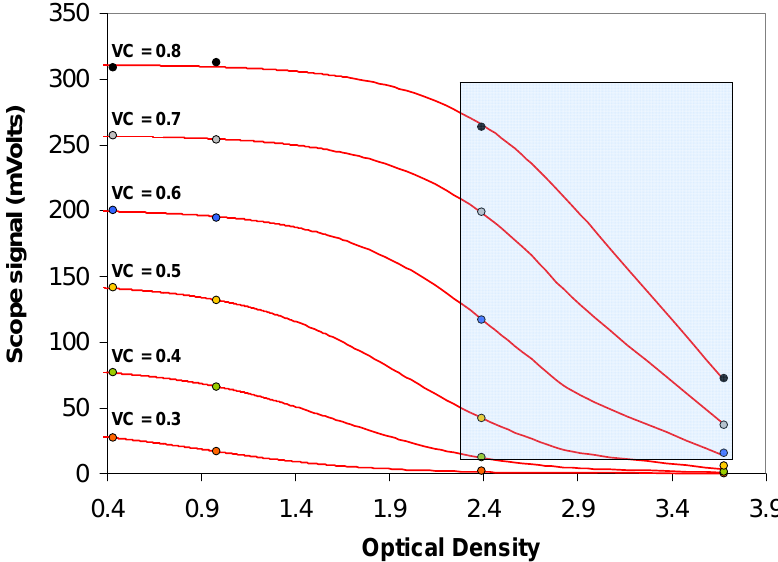
Figure 5. LiDAR returns from a hard target and using different neutral density filters versus the optical density of the filters. The plot shows different curves for different values of the voltage control (gain) of the photomultiplier. The shaded box represents typical working conditions in the filed from the minimum to the maximum